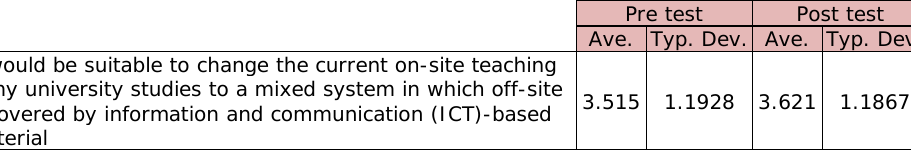
Table 11. “Pre- and